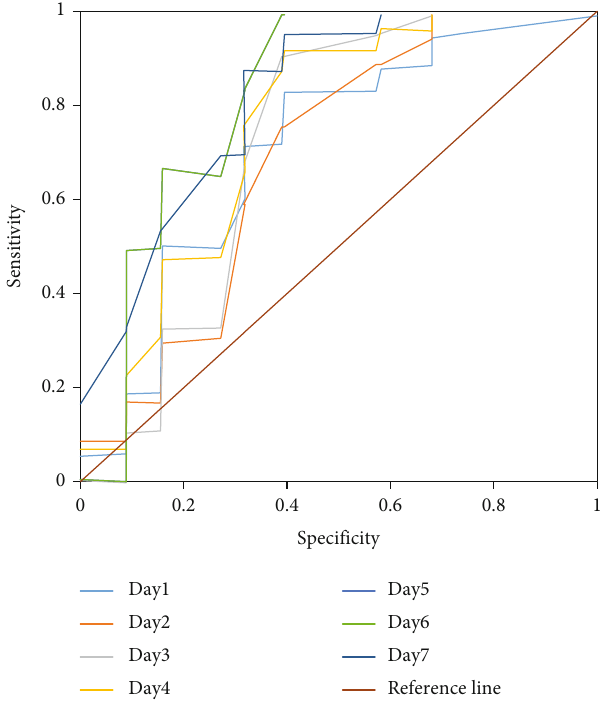
Figure 4: Area comparison under the ROC curve of RRI for AKI diagnosis at di ff erent times in ICU.